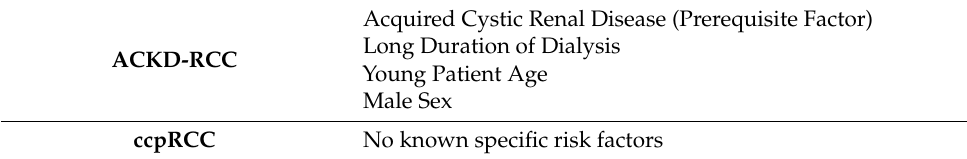
Table 2. Risk factors associated with ACKD-RCC and